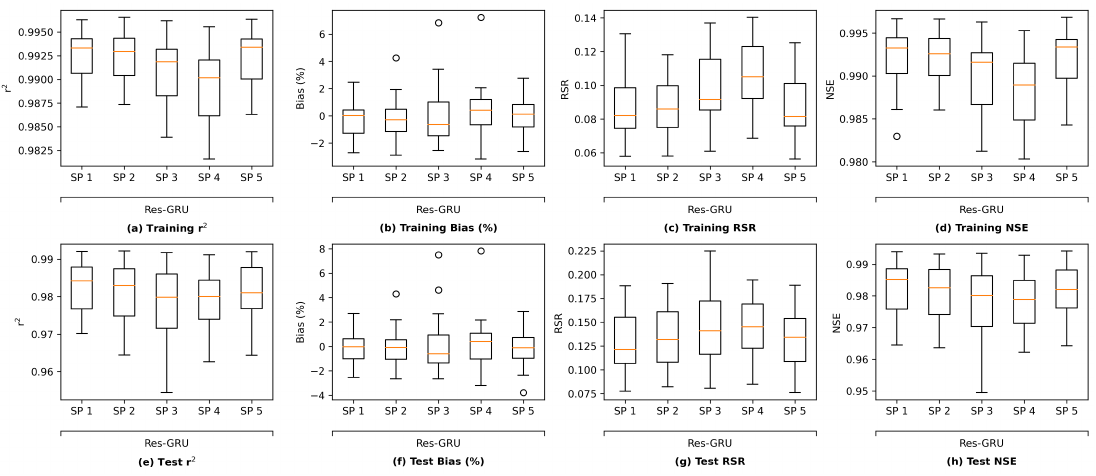
Figure A8. Comparison of the 5-fold cross-validation on the Res-GRU architecture using observed data. “SP” stands for “split”.